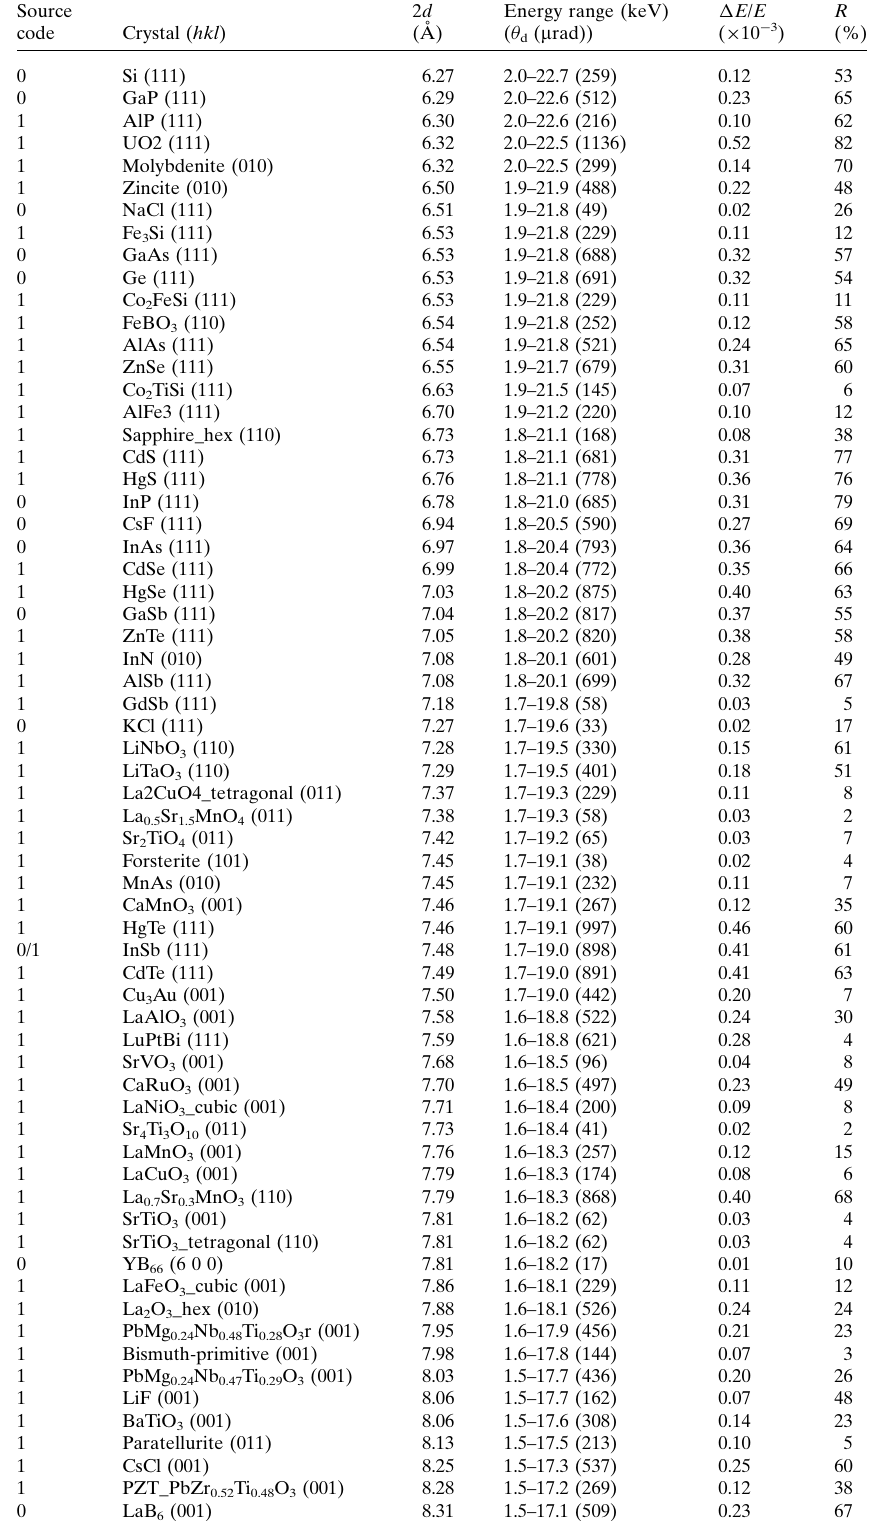
Table 1 Crystals with large 2 d -spacings with the usable photon energy range, Darwin width ( (cid:2) d ), energy resolution ( (cid:2) E / E ) and peak reflectivity ( R ). The lowest energy corresponds to normal incidence. (cid:2) d and R and (cid:2) E / E = (cid:2) d cot( (cid:2) B ), where (cid:2) B is the Bragg angle, are calculated at 1.1 times the lowest energy. Calculations are performed with code developed in this work scanning the crystal structures available in DABAX (source code 0) and Stepanov’s X-ray server (source code 1). Source 2 d (A˚ code Crystal ( hkl )